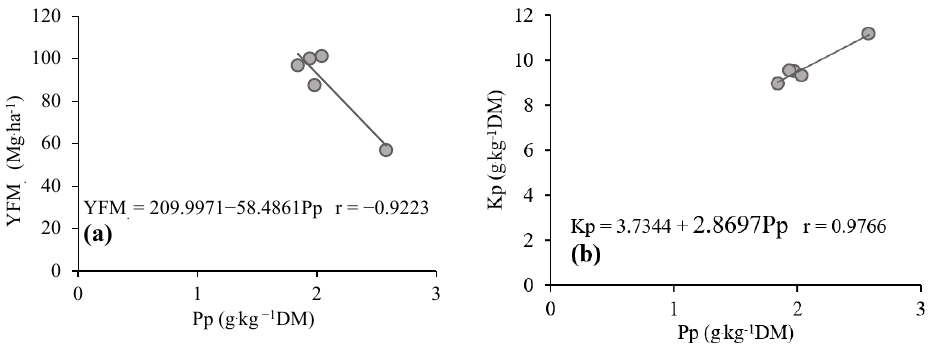
Figure 2. ( a ) The correlations between phosphorus content in maize dry matter (Pp) and its yield (YFM), ( b ) phosphorus ((Pp) and potassium (Kp) content in maize dry matter. The highest potassium content (11.16 g · kg − 1 DM) was found in control plants, while the lowest (8.93 g · kg − 1 DM) in plants treated with NPKMgS + N3 (Table 5). Like in the case of phosphorus, that was caused by the dilution of this chemical element in a large yield.